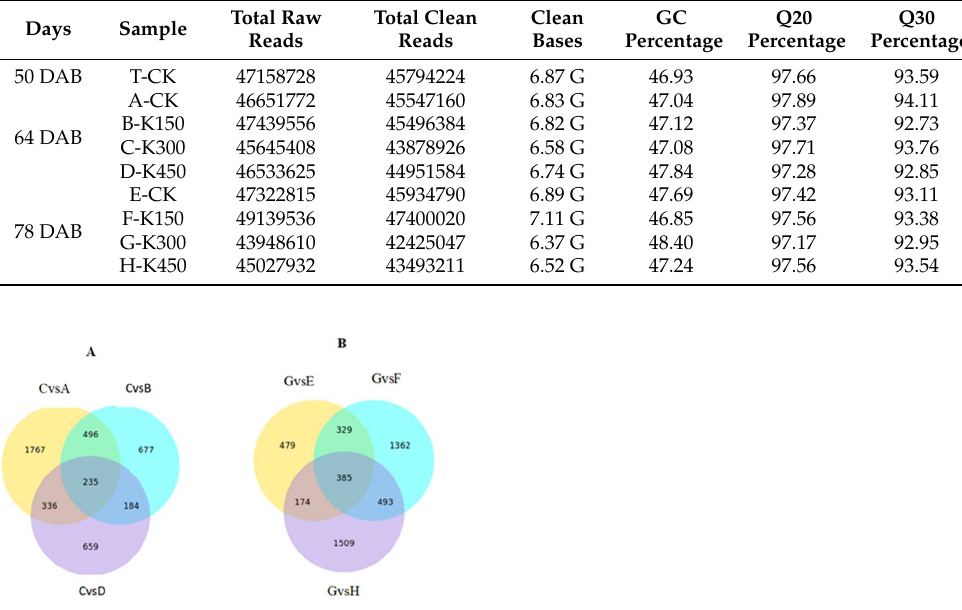
Figure 6. Venn diagram of differentially expressed genes. ( A ): Venn diagram at 64 DAB. ( B ): Venn Figure 6. ( A ): The total number of DEGs, up-regulated and down-regulated at 64 DAB; ( B ): the total number of DEGs, up-regulated and down-regulated at 78 DAB. diagram at 78 DAB. ( p < 0.05 and fold change equal or greater than